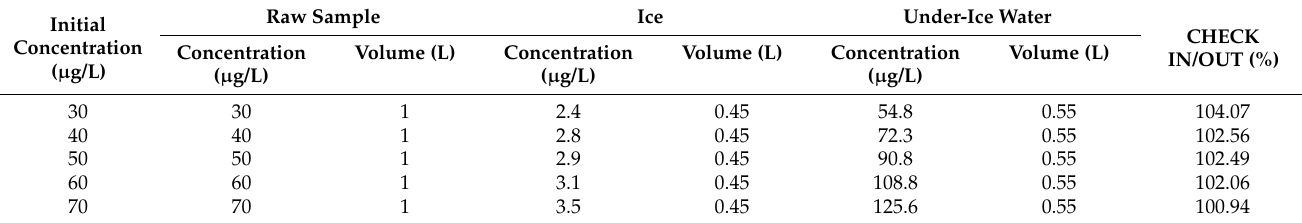
Table A2. Mass conservation verification of the initial concentration.